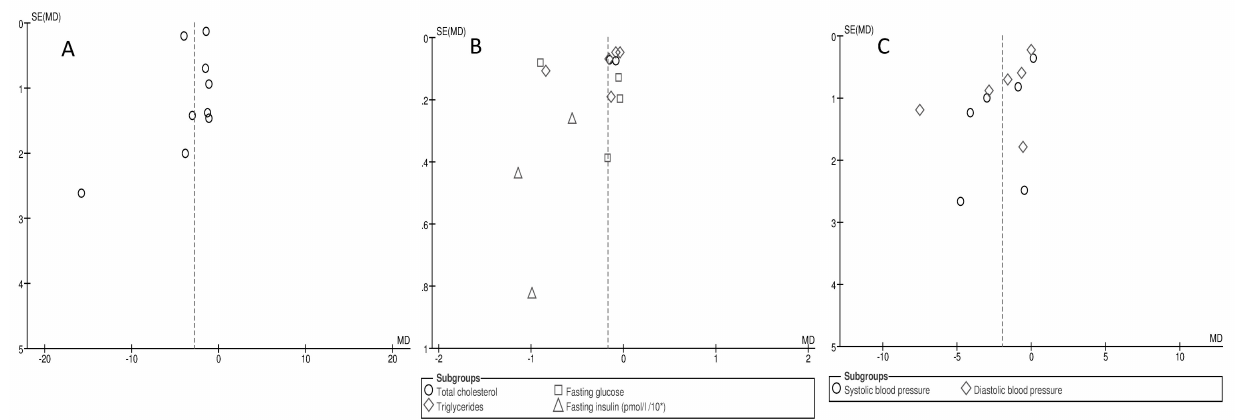
Figure 6. Funnel plot of standard error by standard differences in means of: ( A ) apnea–hypopnea index, ( B ) total cholesterol, triglycerides, glucose and insulin, ( C ) systolic and diastolic blood pressure in selected studies per unit of body mass index